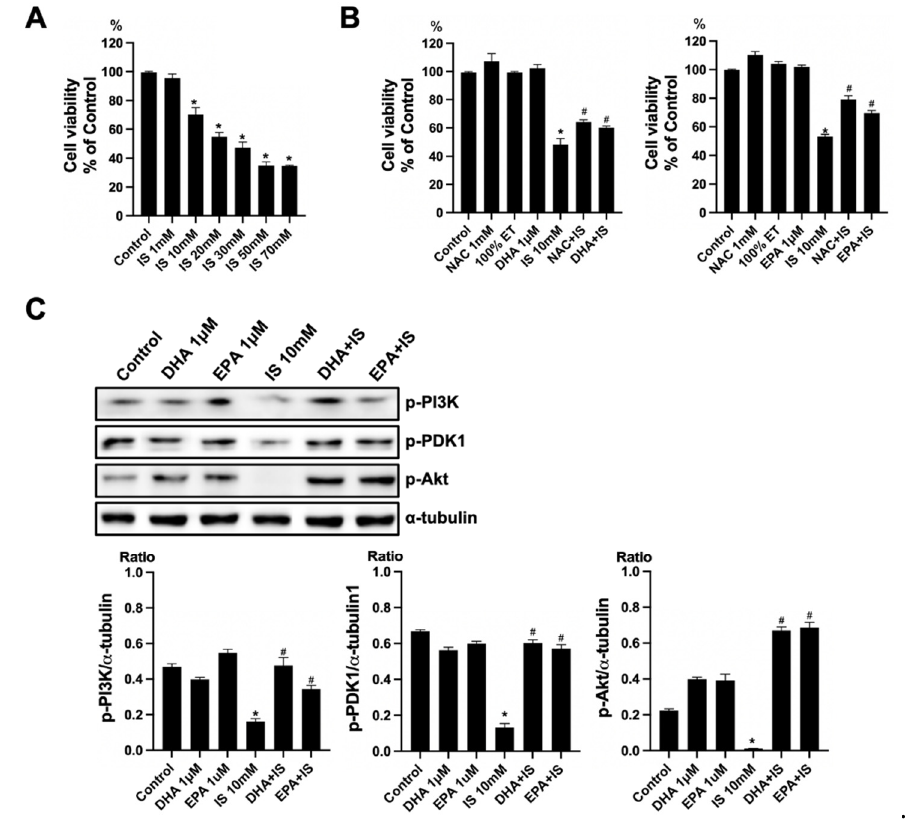
Figure 6. Effects of DHA and EPA on IS toxicity in HT22. ( A ) IS significantly decreased the cell survival in HT22 cells in a dose-dependent manner. ( B ) NAC increased the cell viability in IS-treated HT22 cells. DHA and EPA also increased the cell survival in IS-treated HT22 cells. ( C ) Representative Western blot: IS-treated HT22 cells decreased p-PI3K, p-PDK1, and p-Akt expression. DHA and EPA post-treatment increased p-PI3K, p-PDK1, and p-Akt expression in IS-treated HT22 cells. * p < 0.001 vs. control, # p < 0.001 vs. IS. Bar represents mean ± S.D. (IS, indoxyl sulfate; NAC, N -acetylcysteine; ET, ethanol; MT, methanol; DHA, docosahexaenoic acid; EPA, eicosapentaenoic acid).